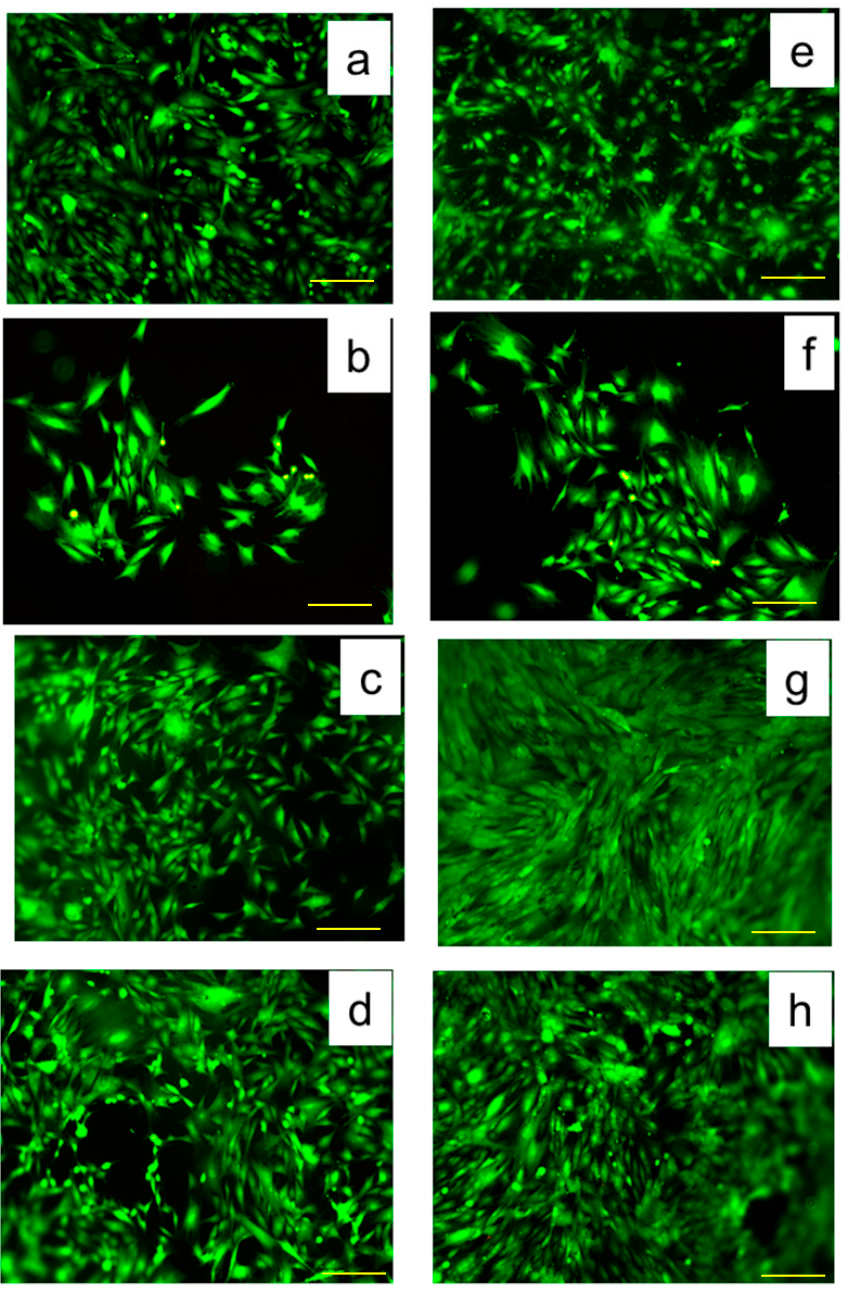
Figure 8. Cell culture (cell line MC3T3-E1) after 48 h for ( a – d ) and after 72 h ( e – h ); control ( a , e ), P0 ( b , f ), P1 ( c , g ), P2 ( d , h ). Scale: 200 µm.